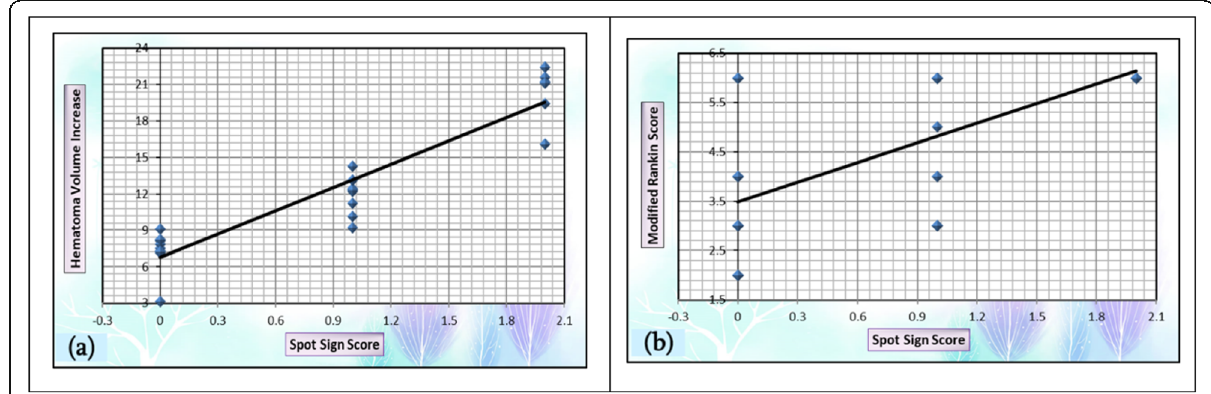
Fig. 4 a , b Positive correlations between spot sign score and each of increased hematoma volume and modified Rankin